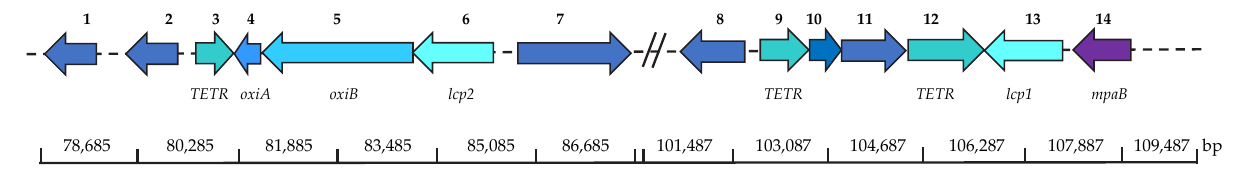
FIGURE 3 | Location of putative lcp1 and lcp2 and adjacent putative genes in Streptomyces sp. AC04842 located on the chromosome based on the MeDuSa assembly. Scaffold 48: 1, LD-carboxypeptidases (EC 3.4. 17.13); 2, lipase 2 (EC 3.1.1.3); 3, transcriptional regulator, TETR-family; 4, isoquinoline 1-oxidoreductase alpha subunit ( oxiA ); 5, isoquinoline 1-oxidoreductase alpha subunit ( oxiB ); 6, latex clearing protein gene 1 ( lcp1 ); 7, long-chain fatty acid CoA ligase (EC 6.2.1.3). Scaffold 5: 8, alpha-methylacyl-CoA racemase (EC 5.1.99.4); 9, transcriptional regulator, TetR-family; 10, FIG01128310: hypothetical protein; 11, alcohol dehydrogenase (EC 1.1.1.1); 12, transcriptional regulator, TETR-family; 13, latex clearing protein gene 2 ( lcp2 ); 14, oxygenase MpaB family protein. Putative gene location was detected using the SEED Viewer (Overbeek et al., 2013) and SnapGene Viewer. The putative gene identity was compared with UniProt (UniProt Consortium, 2021) and GenBank